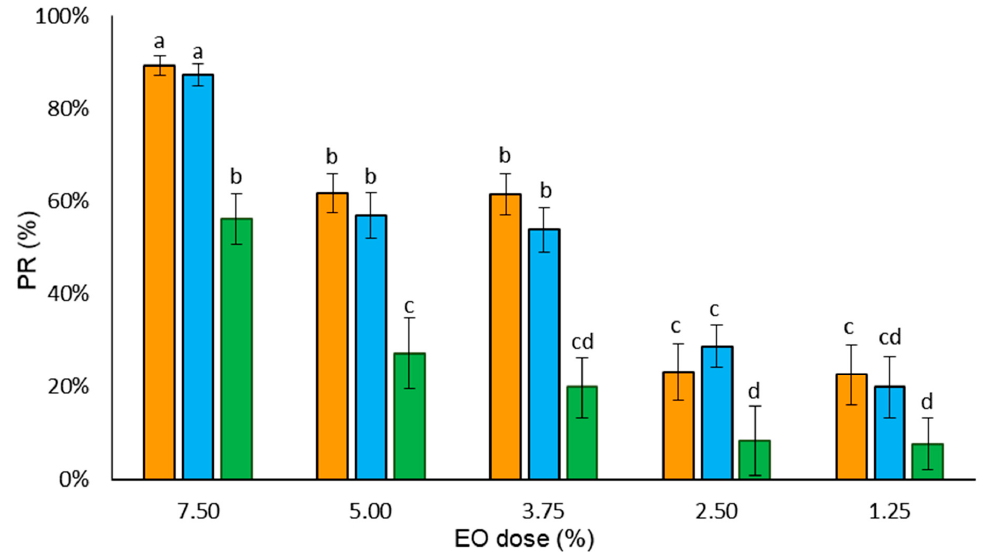
Figure 1. Oviposition deterrence (mean percent repellency ± SE) of the essential oil-based nano- emulsions toward B. oleae females in no-choice trials. Four replicates (n = 10) were provided for every EO dose. Orange bars = anise EO; blue bars = fennels EO; green bars = mint EO. Different letters indicate significant differences among the PR values (Dunn’s test, p < 0.05).